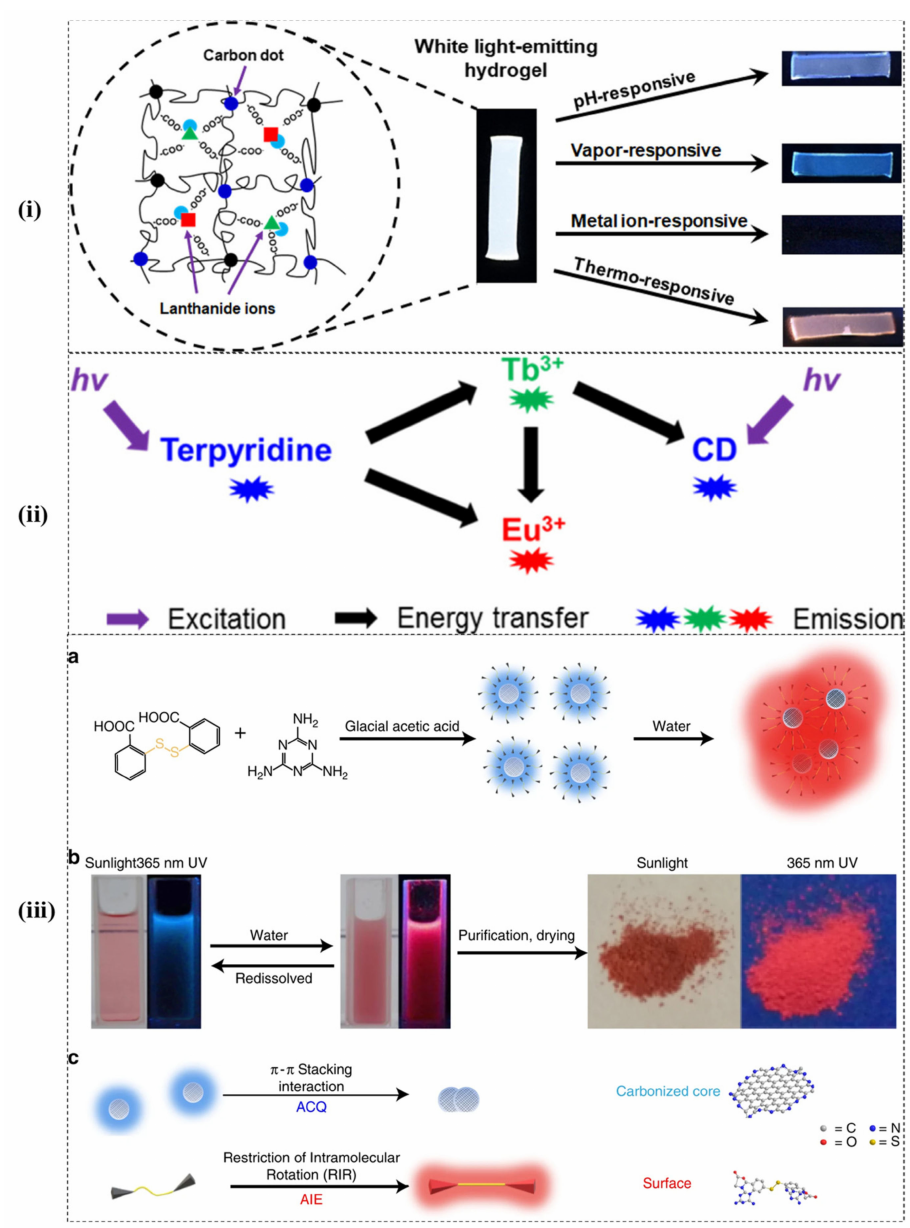
Figure 4. ( i ) Multi-stimuli responsive behaviour of the CDs, ( ii ) Proposed energy-transfer mech- anism in white-light-emitting hydrogel [125] (Reproduced with permission). ( iiia ) Formation of H-CD monomers and their aggregates (the disulphide bond in dithiosalicylic acid molecular is highlighted with yellow). ( iiib ) Photographs of the H-CD’s two-switch-mode luminescence principle. ( iiic ) Fluorescence principle and proposed structure of H-CD’s core and surface [129] (Reproduced with